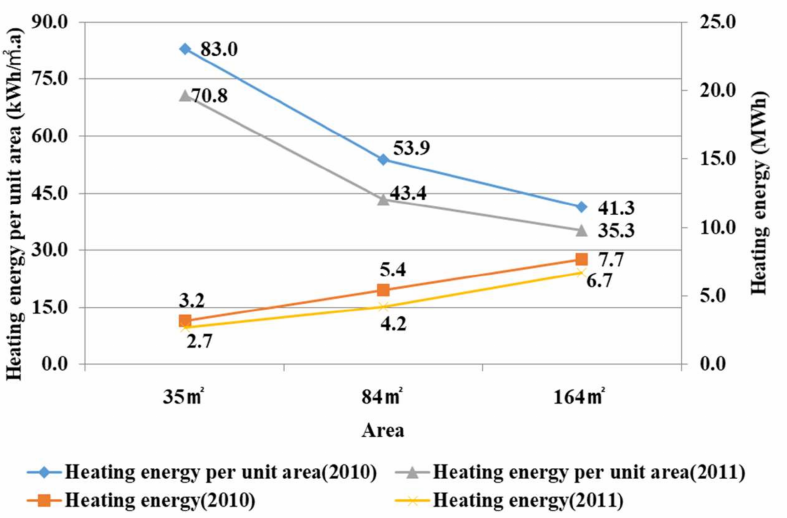
Figure 11. Measured heating consumption and heating energy per unit